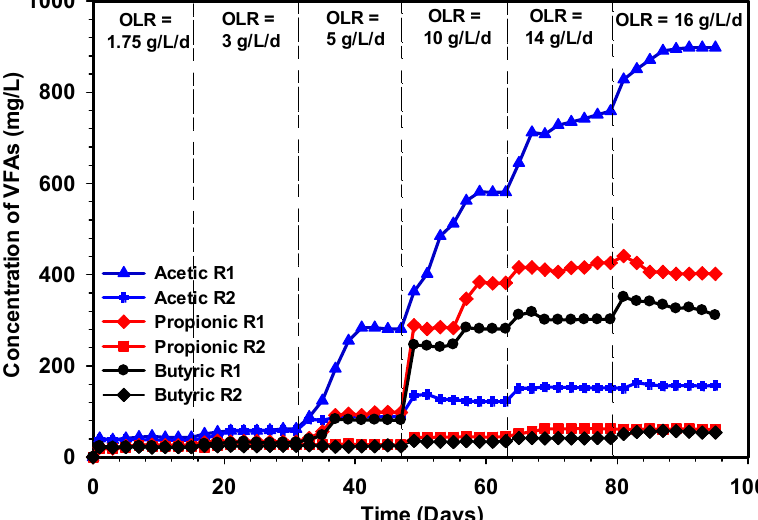
Figure 9. Variation in the VFA concentration for the R1 and R2 reactors.